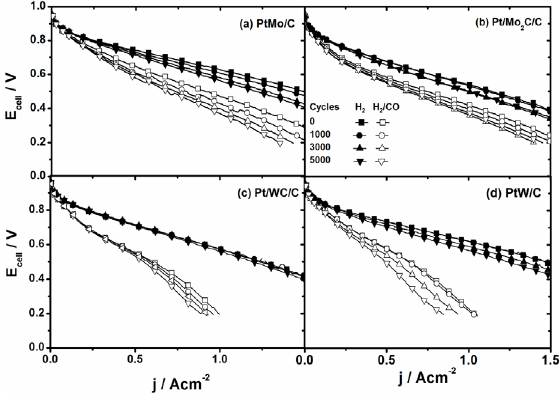
Figure 9 - Single cell polarization curves measured at 85 o C for different catalysts after various voltage cycles during the AST: ( a ) The PtMo/C, Pt/Mo were supplied with pure H cathodes were supplied with O